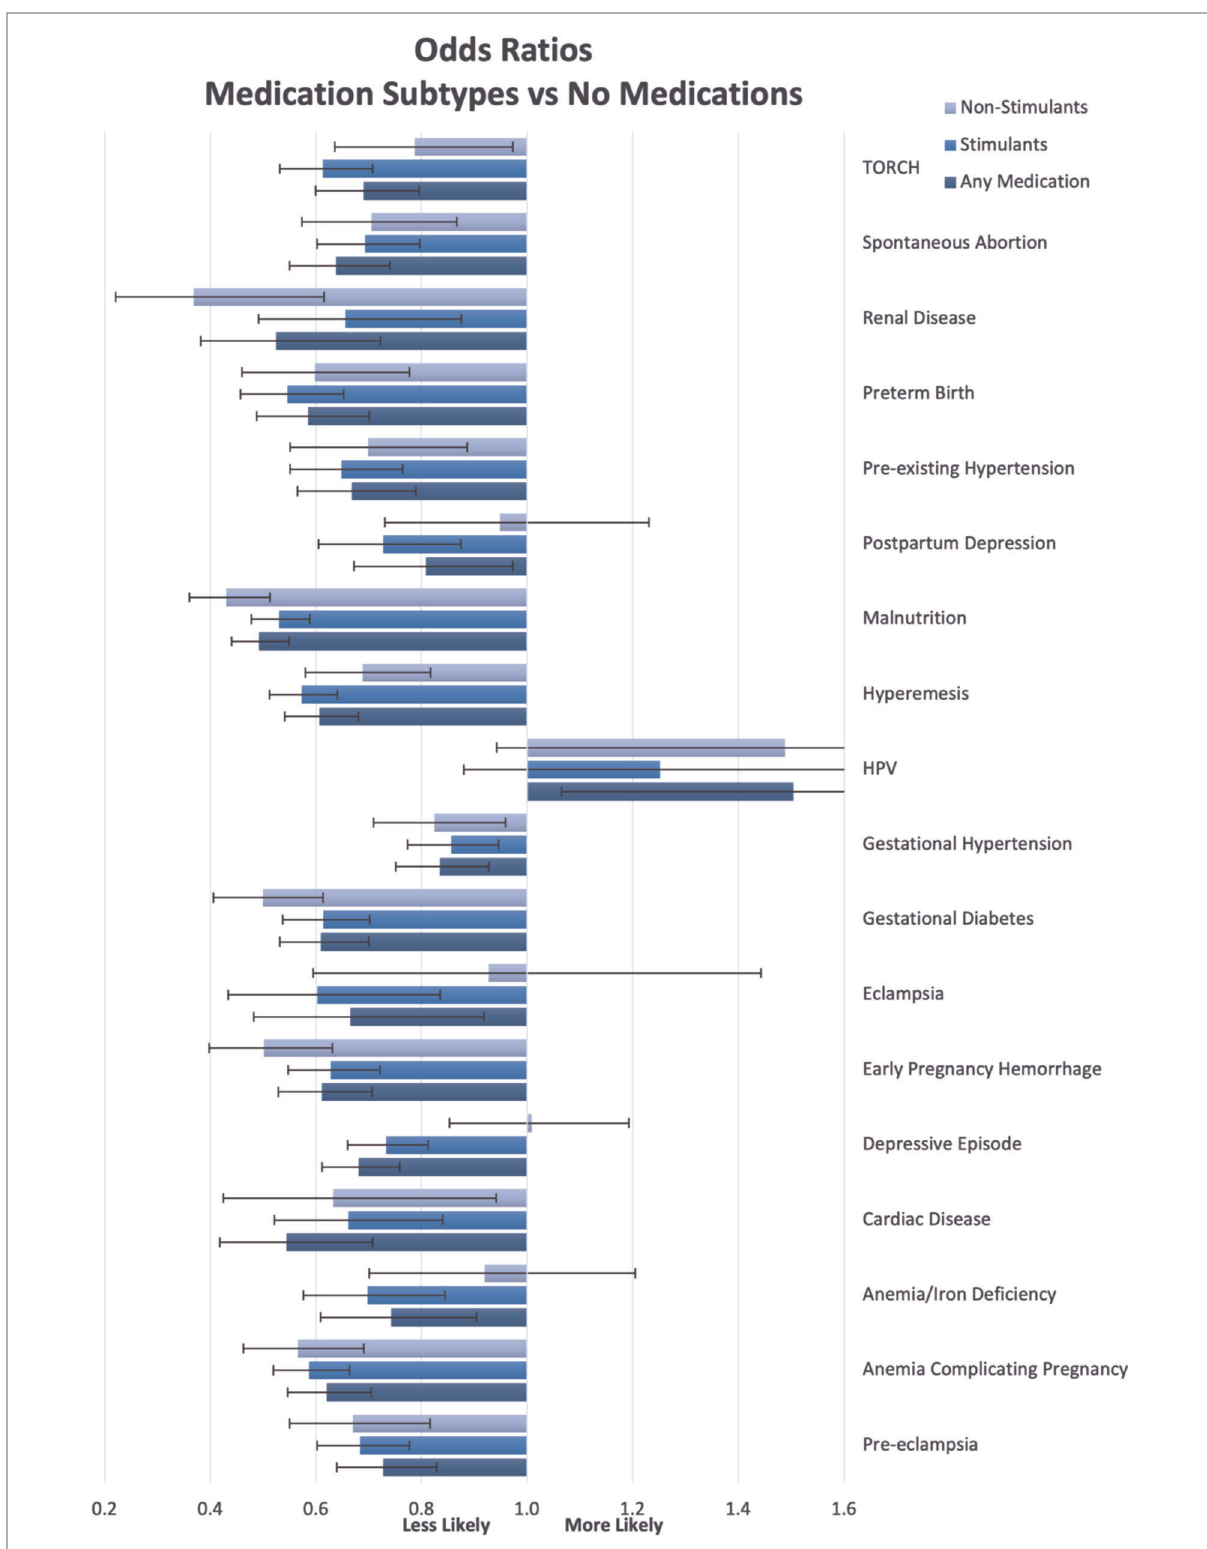
FIGURE 2 Odds ratio by outcome by medication type. Con fi dence bars represent 95%